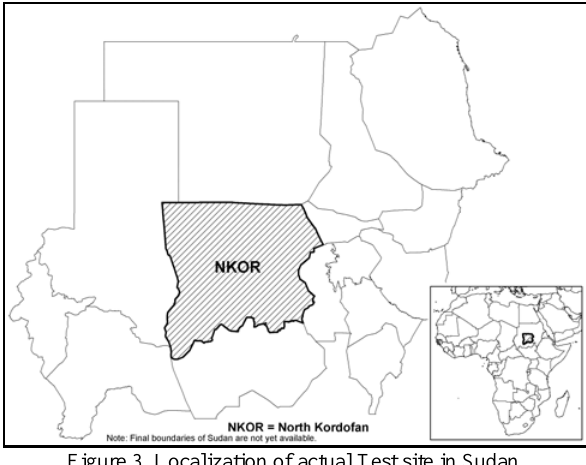
Figure 3 Localization of actual Test site in Sudan (North Kordofan state, approx.